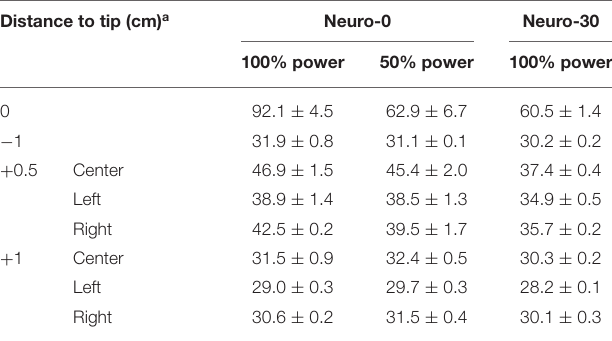
TABLE 1 | Thermal spread with distance in front of or behind the tip and with the xenon light source. Distance to tip (cm) a